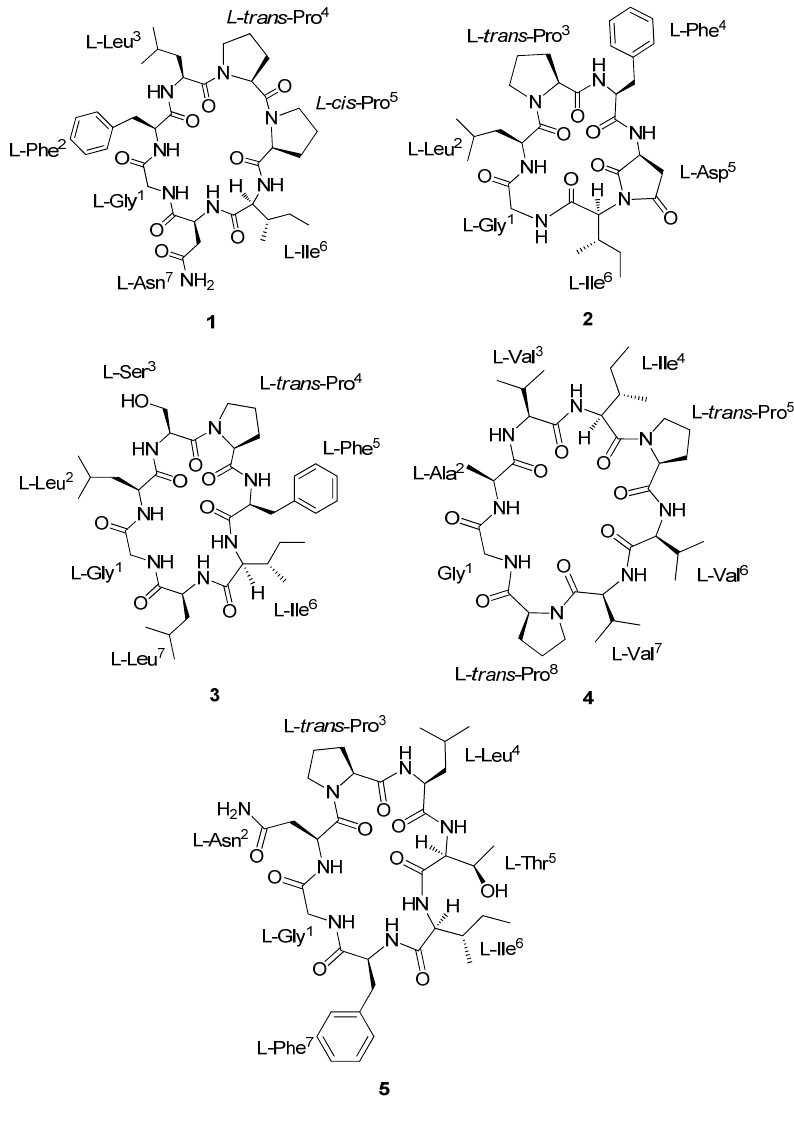
Figure 1. Structures of compounds 1 – 5 .